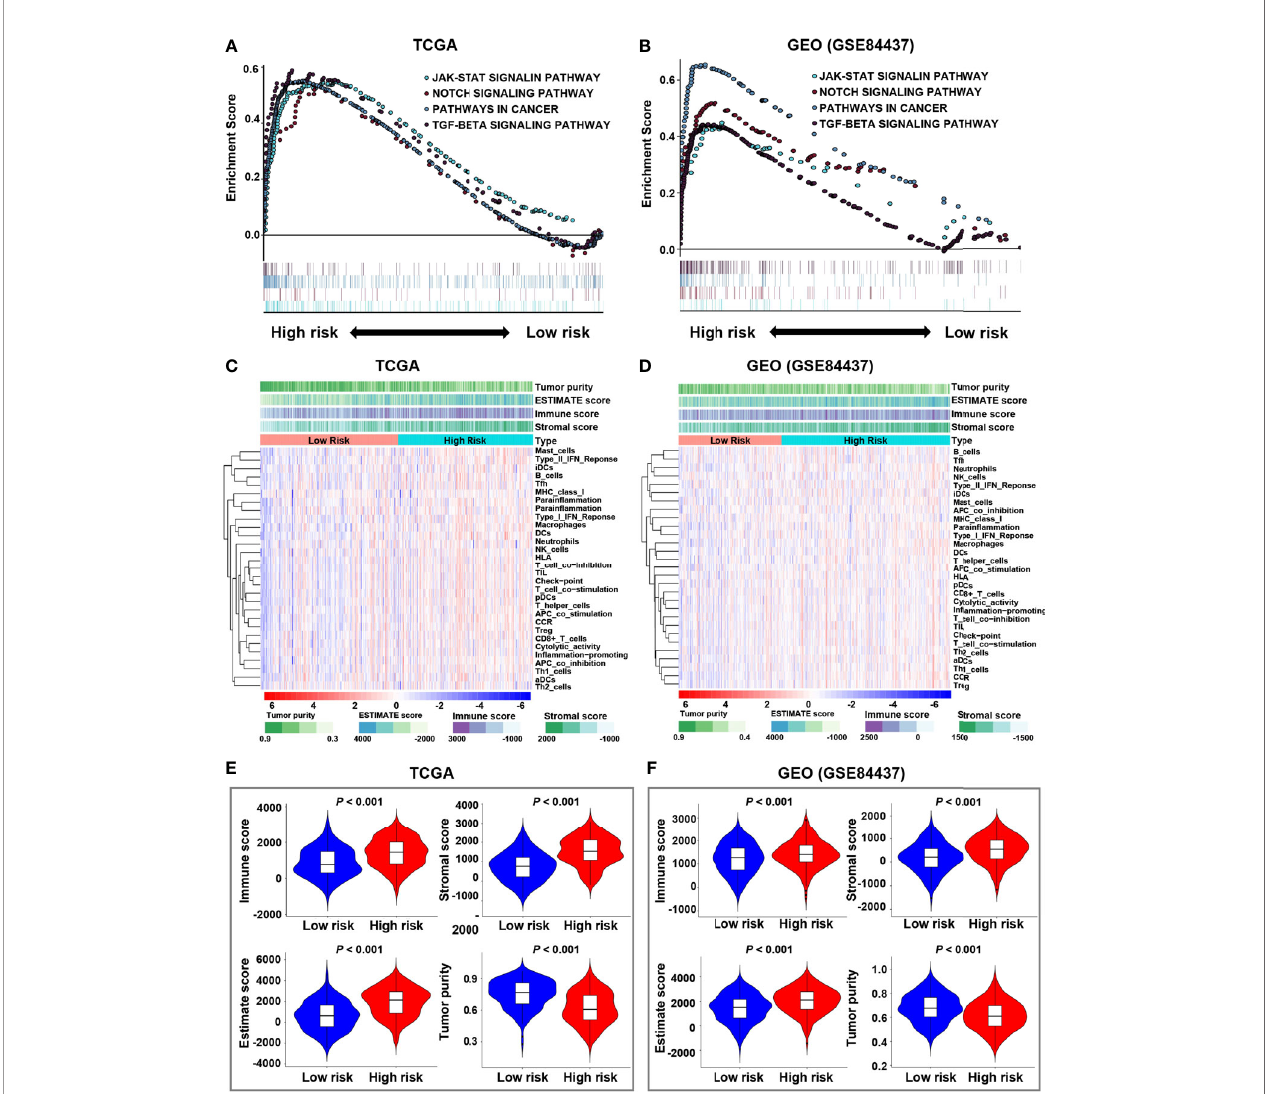
FIGURE 3 | Enrichment of pathways related to hypoxia and analysis of tumor immune microenvironment. (A, B) The enrichment plots show the signaling pathways related to hypoxia in the screening and validation cohorts. (C, D) The heatmaps show 29 immune-related gene sets, immune score, stromal score, ESTIMATE score and tumor purity in the screening and validation cohorts. (E, F) The relationship between risk score and immune score, stromal score, ESTIMATE score, and tumor purity in the screening and validation